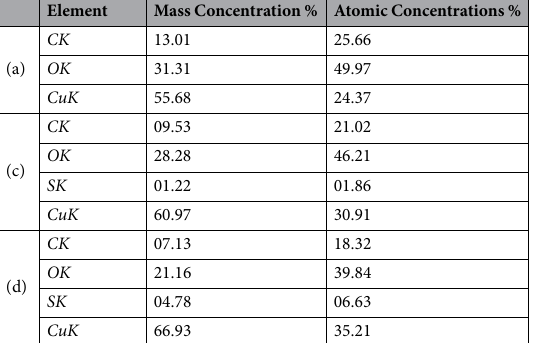
Table 3. Content of EDS spectrum elements in semi-quantitative analysis results.